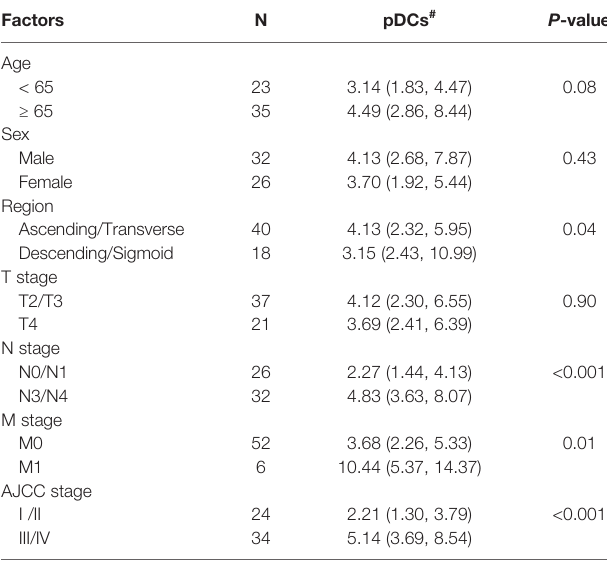
TABLE 2 | Correlations between tumor in fi ltrating pDCs and clinicopathological factors of colon cancer. Factors